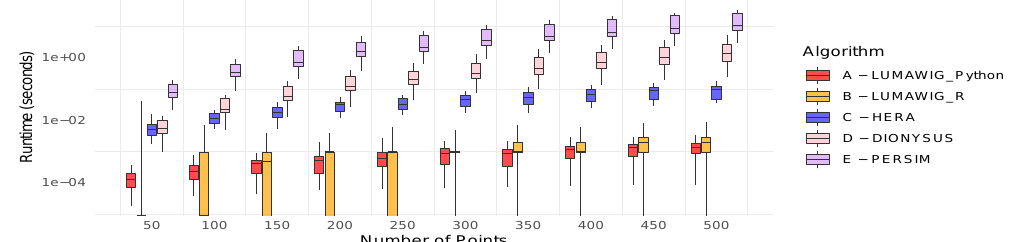
Figure 3. Boxplots of running times (seconds in log scale) from different